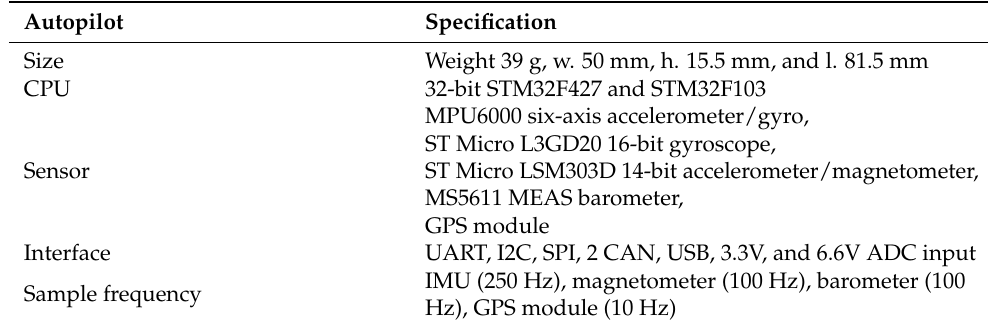
Table A1. The UAV commercial self-designed autopilot